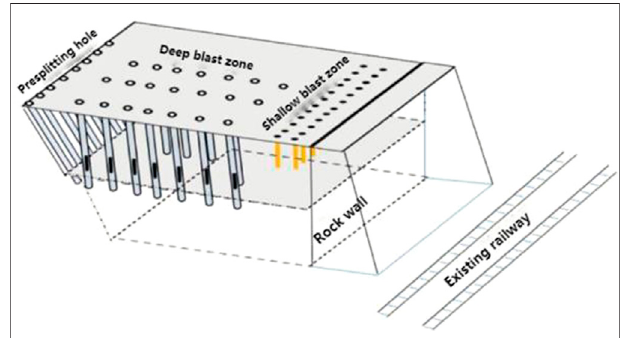
FIGURE 1 | Schematic diagram of rock wall blasting.